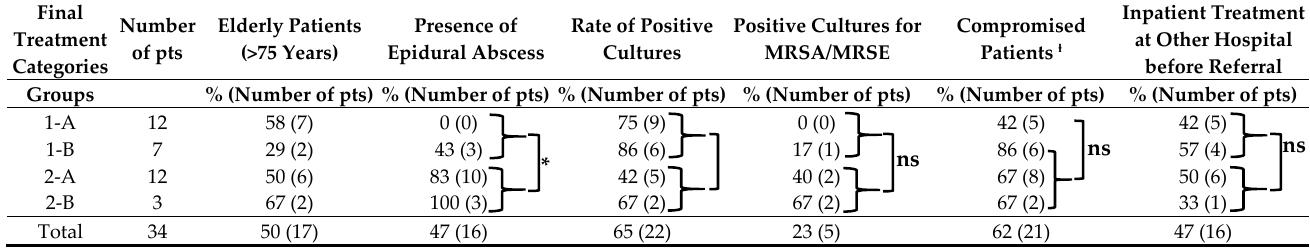
Table 1. Risk factors that necessitated more complicated treatment options.